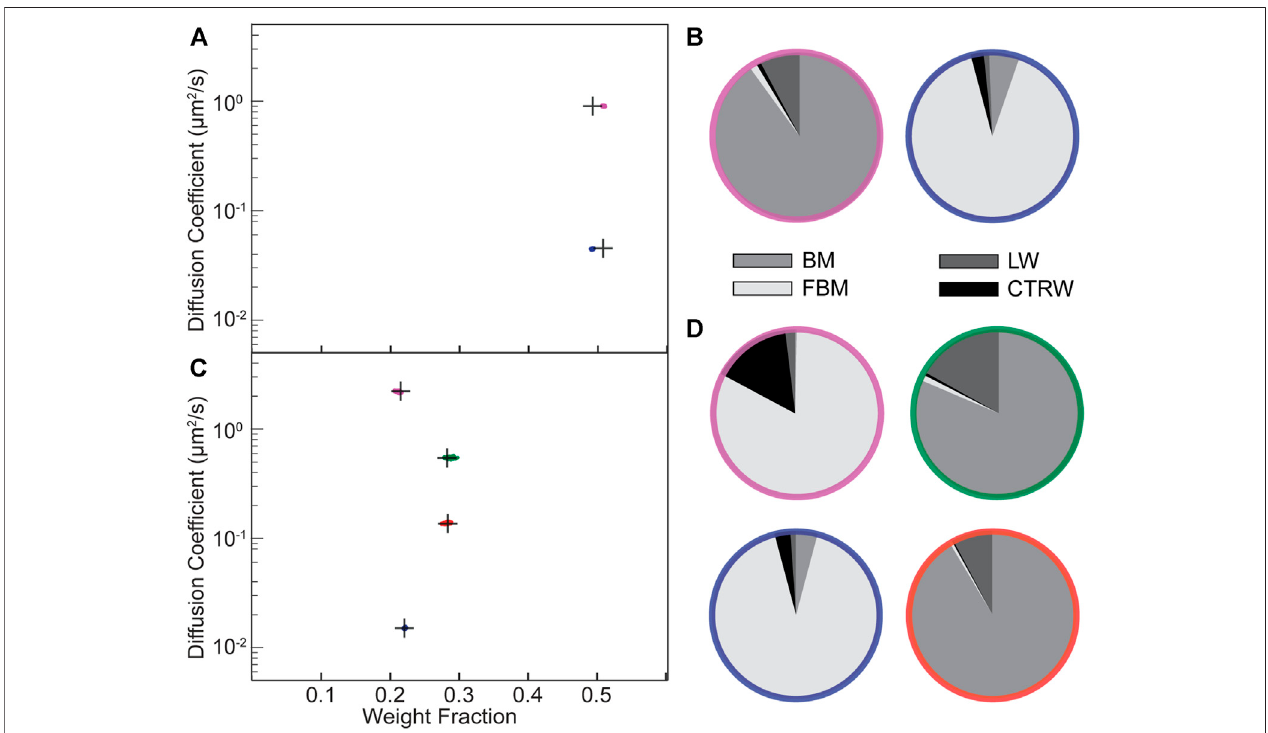
FIGURE 3 | Validation of the NOBIAS-RNN module with simulated trajectories containing mixtures of different diffusion types. (A , C) The HDP-HMM module identi fi esdistinctmobilitystates(coloredclusters).Eachpointrepresentstheaverageapparentsingle-moleculediffusioncoef fi cient, D ,vs.weightfractionineachdistinct mobility state at each iteration of the Bayesian algorithm saved after convergence. The black crosses indicate the ground truth input for these simulated trajectories. (A) Two-state mixture comprising a subdiffusive Fractional Brownian Motion (FBM) state with lower D and a Brownian Motion (BM) state with higher D . (B) The NOBIAS-RNN determines the probability that the diffusion type for each diffusive state in (A) is classi fi ed as BM, FBM, Continuous Time Random Walk (CTRW), or Lévy Walk (LW). The fi nal probability for each diffusive state is the average of the classi fi cation probability of its track segments weighted by the segment length. The color of each pie chart indicates the diffusive state corresponding to the color in (A) . (C) Four-state mixture comprising a subdiffusive FBM state, two BM states, and a superdiffusive FBM state with D in ascending order. (D) Diffusion type classi fi cation probability pie chart for each diffusive state in (C) . The fi nal probability for each diffusive state is the average of the classi fi cation probability of its track segments weighted by the segment length and the color of each pie chart indicates the diffusive state corresponding to the corresponding color in (C)